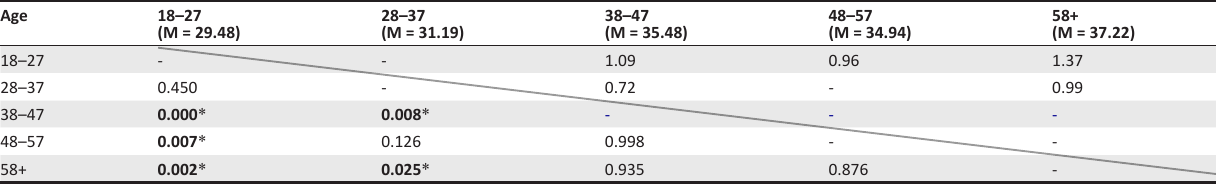
TABLE 6: Tukey tests and Cohen’s d for vigour , according to age. Age